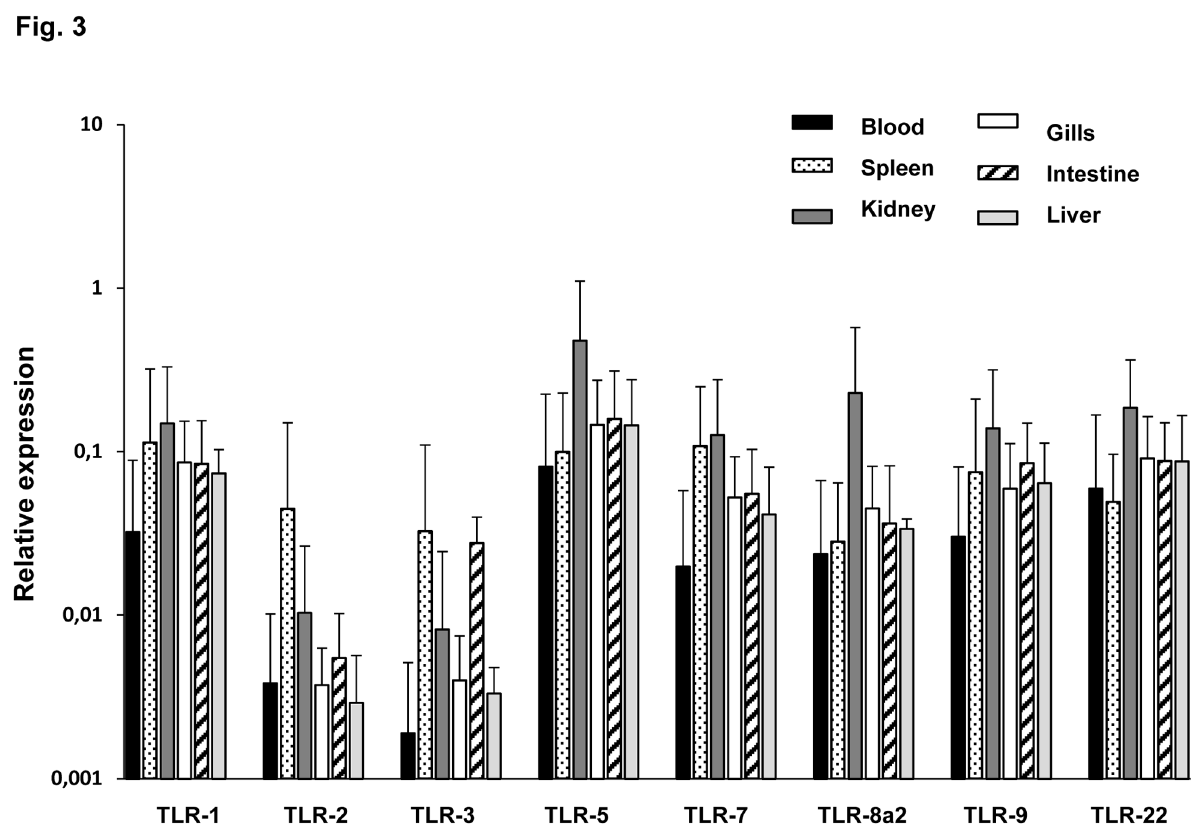
Figure 3. Levels of TLR transcription in sorted IgM + cells. Constitutive levels of transcription of TLRs in IgM + cells from different trout tissues. The amount of TLR-1, -2, -3, -5, -7, -8a2, -9 and -22 mRNA was evaluated through real time PCR in duplicates. Data from 5 independent experiments are shown as the mean gene expression relative to the expression of an endogenous control (EF-1α)